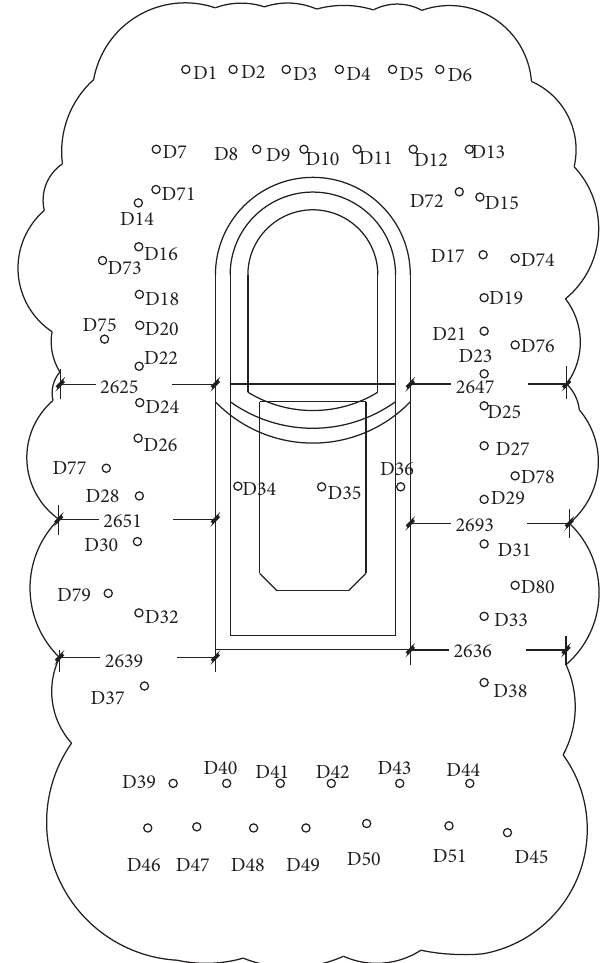
Figure 15: Forecast section of the frozen soil wall (unit: mm).